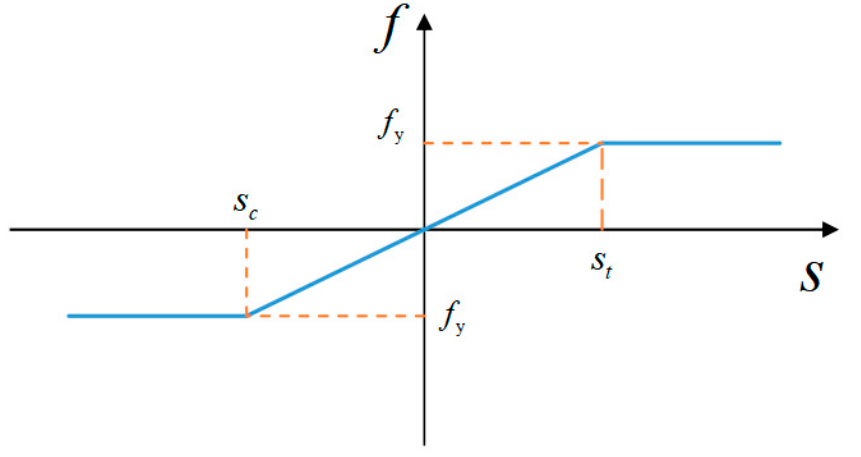
Figure 2. Reinforcement constitutive model.